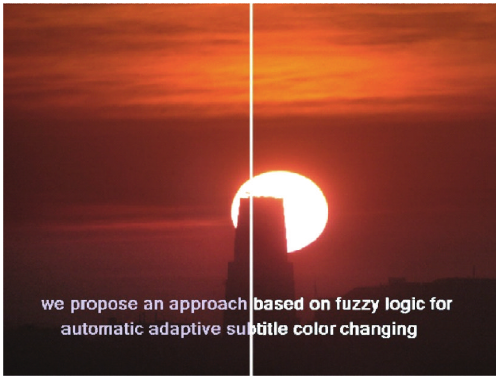
Figure 13: The subtitle of Figure 12 compared to the fixed